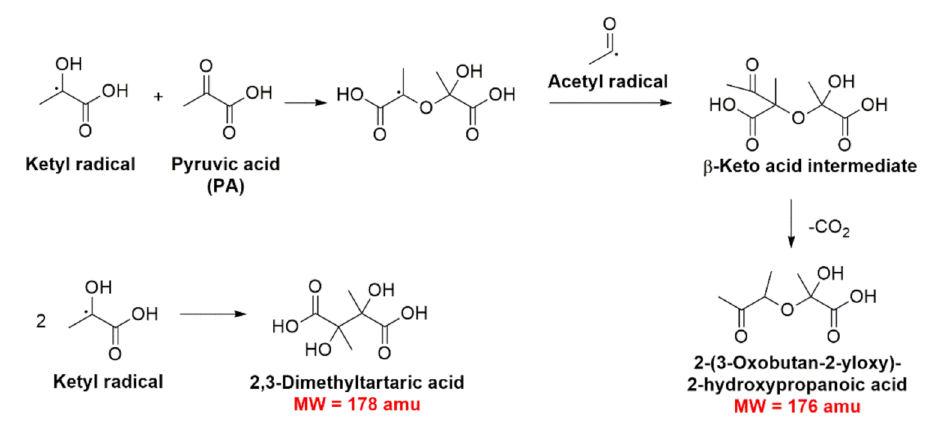
Scheme 9. Formation of the organic products of PA photochemistry in water and ice from ketyl and acetyl radical intermediates identified by Guzman et al. [5,80,82].